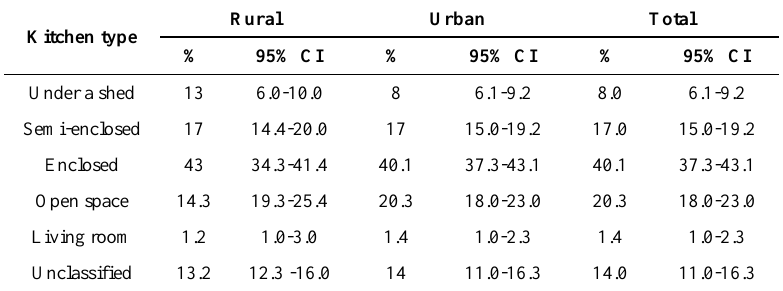
Table 2. Showing types of cooking environments in the rural and urban population of the study